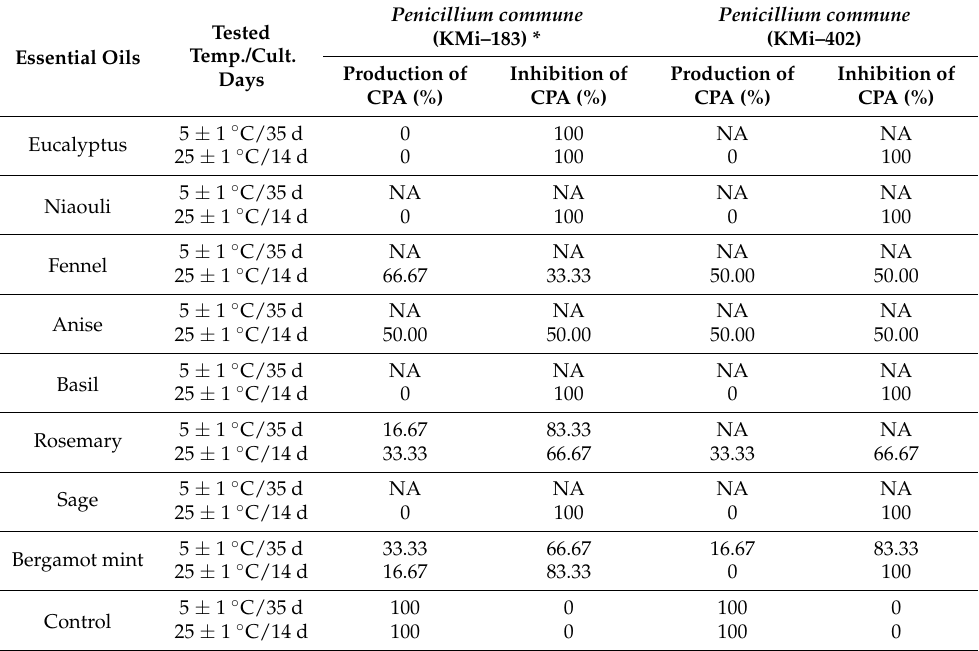
Table 4. In vitro inhibitory effects (in %) of essential oils (500 µ L/L of air) at 25 ± 1 ◦ C after 14 days of cultivation and at 5 ± 1 ◦ C after 35 days of cultivation on the mycotoxin production by Penicillium commune strains (PDs divided into three sectors in two independent repetition were used ( n =